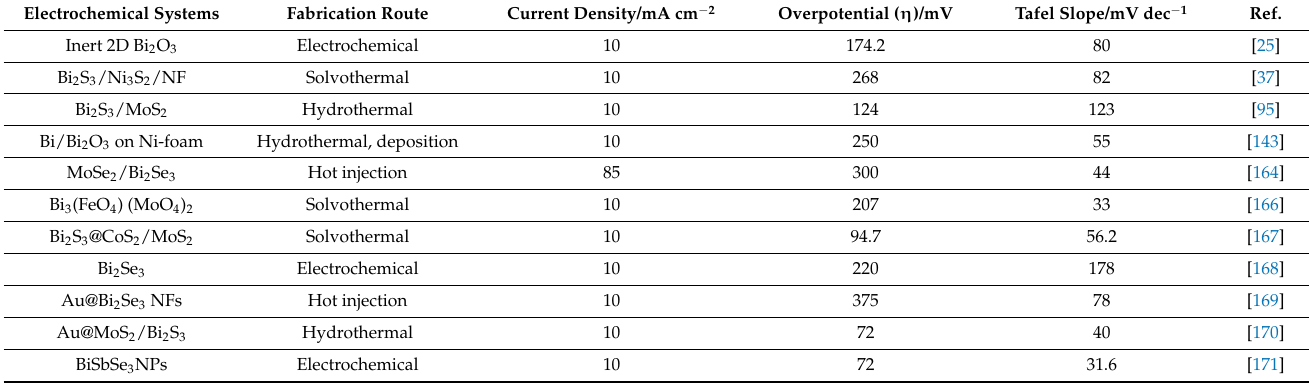
Table 3. Electrochemical efficiency of Bi-based heterostructures for HER